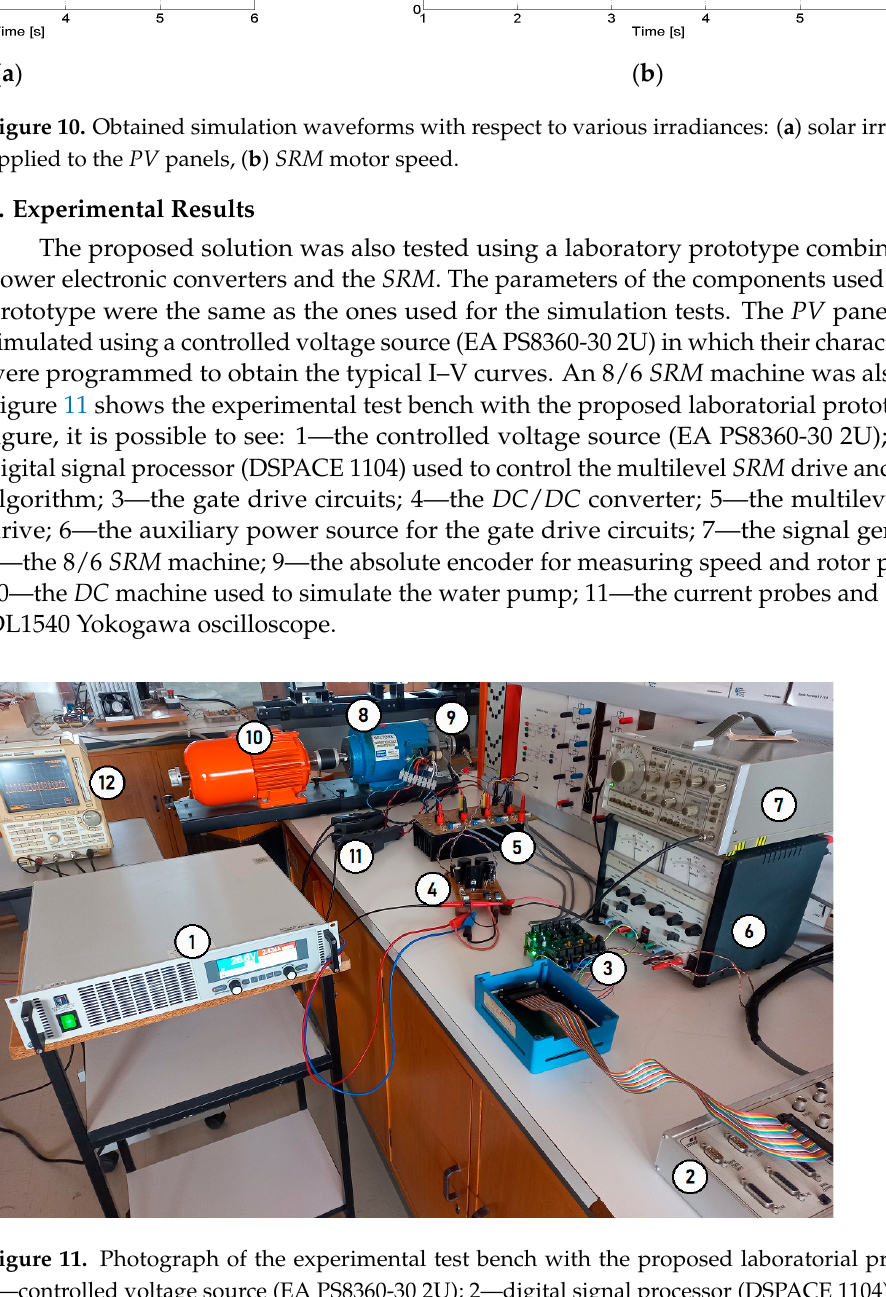
Figure 10. Obtained simulation waveforms with respect to various irradiances: ( a ) solar irradiation applied to the PV panels, ( b ) SRM motor speed.